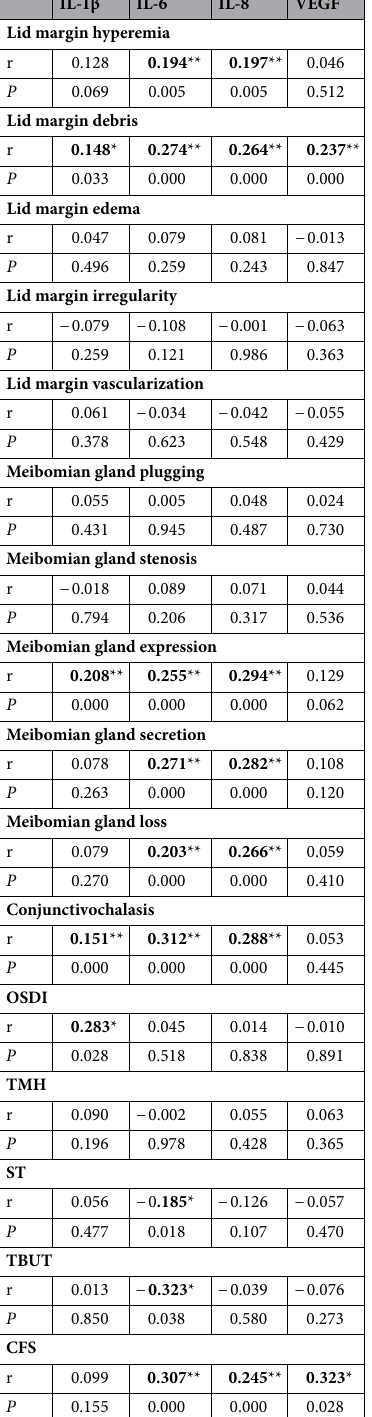
Table 4. Correlations between the cytokine concentrations and ocular surface status during short-term exposure. OSDI ocular surface disease index, TMH tear meniscus height, ST Schirmer’s I test, TBUT tear film break-up time, CFS corneal fluorescein staining, IL-1β interleukin 1 beta, IL-6 interleukin 6, IL-8 interleukin 8, VEGF vascular endothelial growth factor. * P < 0.05, two-tail, ** P < 0.01, two-tail for Spearman correlation